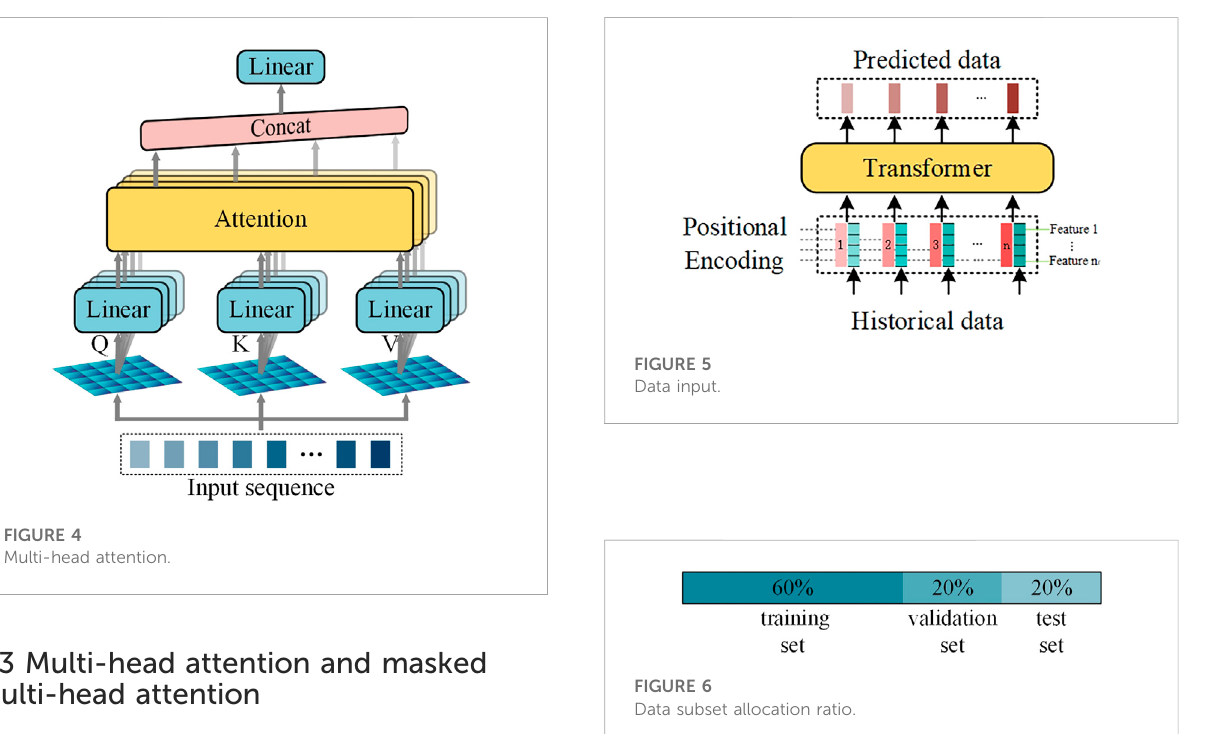
FIGURE 6 Data subset allocation